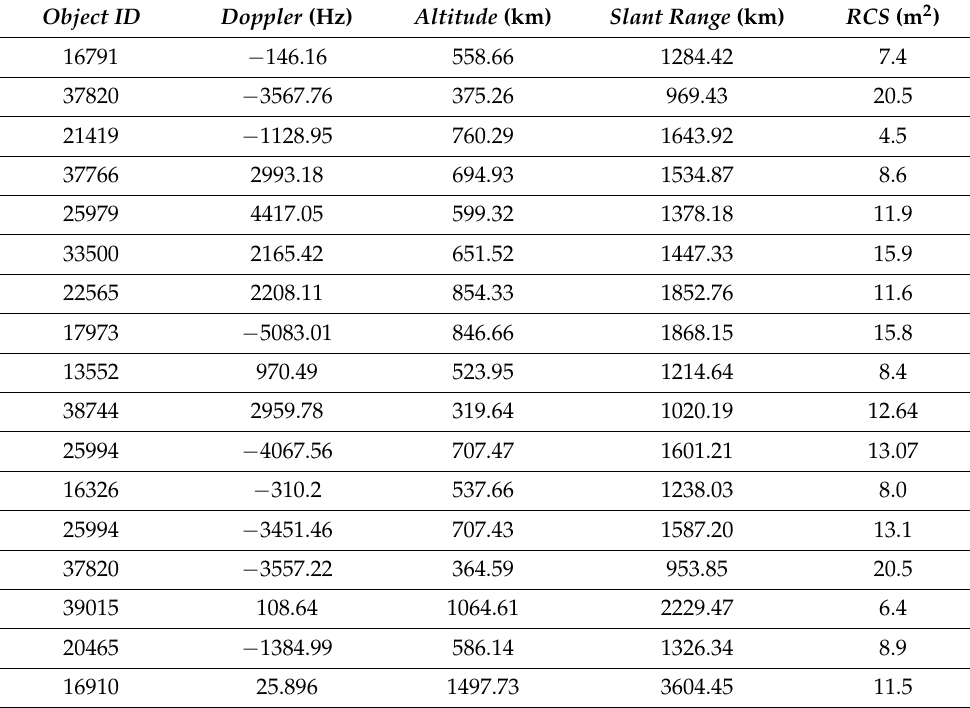
Table 1. Summary of the debris measurements by the Bistatic Radar for LEO Survey (BIRALES) in